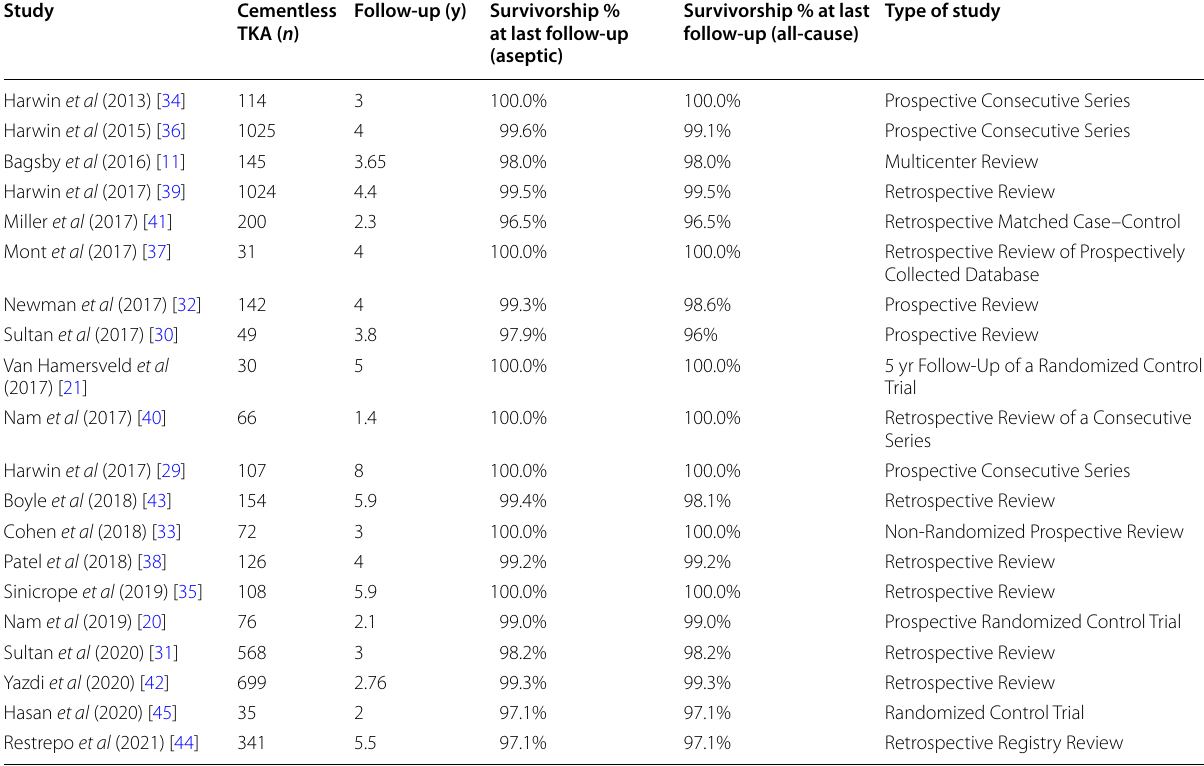
Table 1 Studies included in the systematic review for analysis